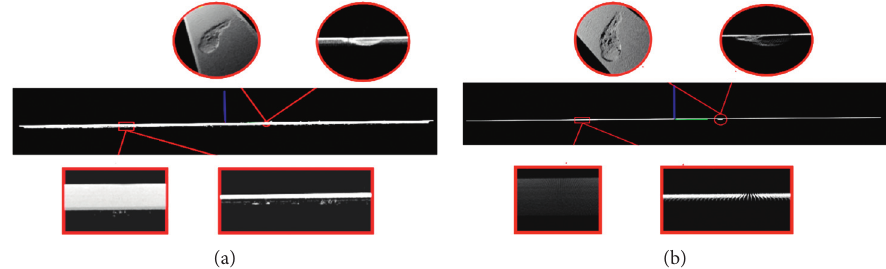
Figure 6: The results of point cloud denoising for the roller with a contact surface width of 5 mm. (a) Point cloud before the denoising roller and (b) point cloud after the denoising roller.